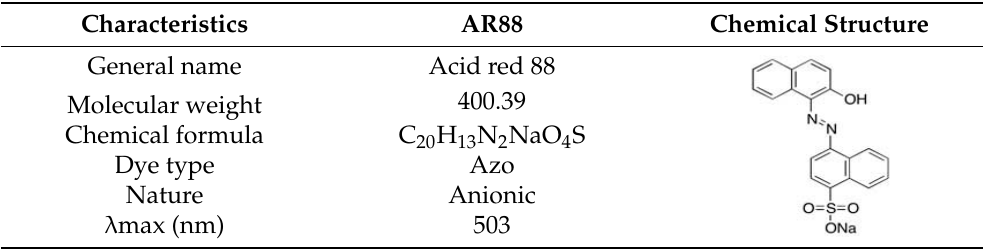
Table 1. General characteristics of AR88.